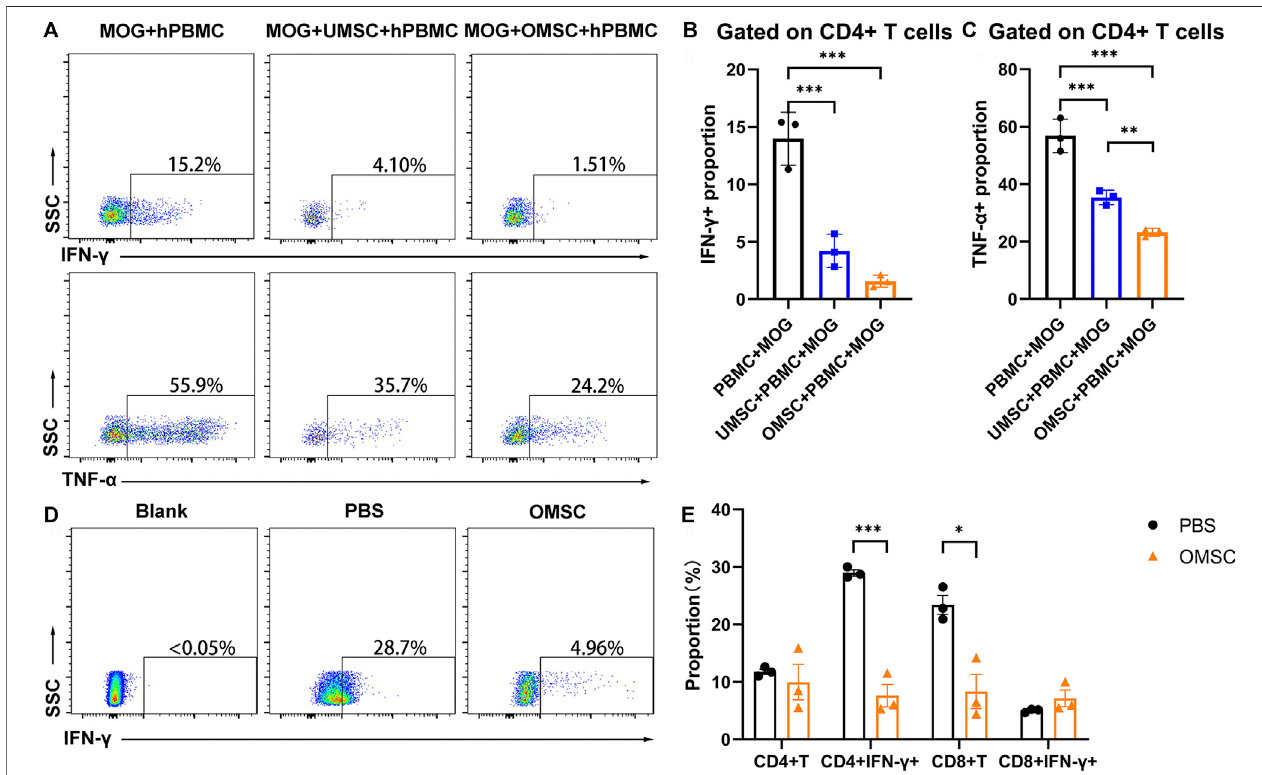
FIGURE 4 | OMSC treatment reduced CD4+IFN- γ + T lymphocytes: (A) Proportion of CD4+IFN- γ + T cells (Th1) and CD4+TNF- α + T cells in human lymphocyte single culture, UMSC, and OMSC co-culture groups. (B, C) CD4+IFN- γ + T cells and CD4+TNF- α + T cells of the co-culture system. ** p < 0.01 and *** p < 0.001. (D) Proportion of CD4+IFN- γ + T cells in mice splenic lymphocytes in the OMSC treatment group and PBS group. (E) CD4+T cells and CD8+T cells and their IFN- γ expression by splenic lymphocytes in the mice of the OMSC treatment group and PBS group ( n (cid:1) 3). * p < 0.05 and *** p <